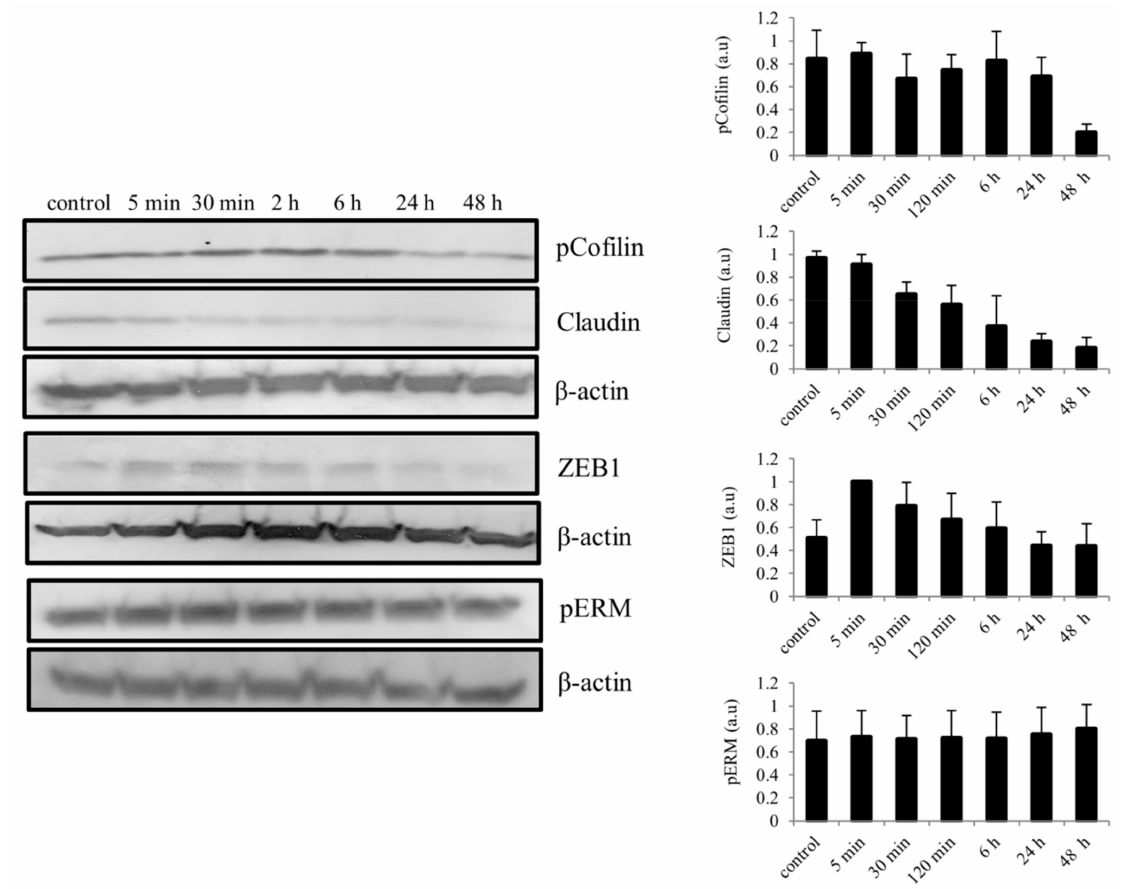
Figure 7. Activation of EMT-related signaling molecules in epithelial cells following the stimulation of BMP7 (100 ng/mL). Total protein lysates were collected at time points 5 min, 30 min, 2, 6, 24 and 48 h and subjected to immunoblot analysis. Differences in the phosphorylation levels (ERM and cofilin) and total protein levels (Zeb1 and claudin) was observed and quantified using ImageJ software and the values were normalized to the corresponding β -actin signal. Data represent mean ± standard deviation of the phosphorylation levels or total protein levels shown as arbitrary units from more than three independent experiments. One representative immunoblot of at least three independent experiments is